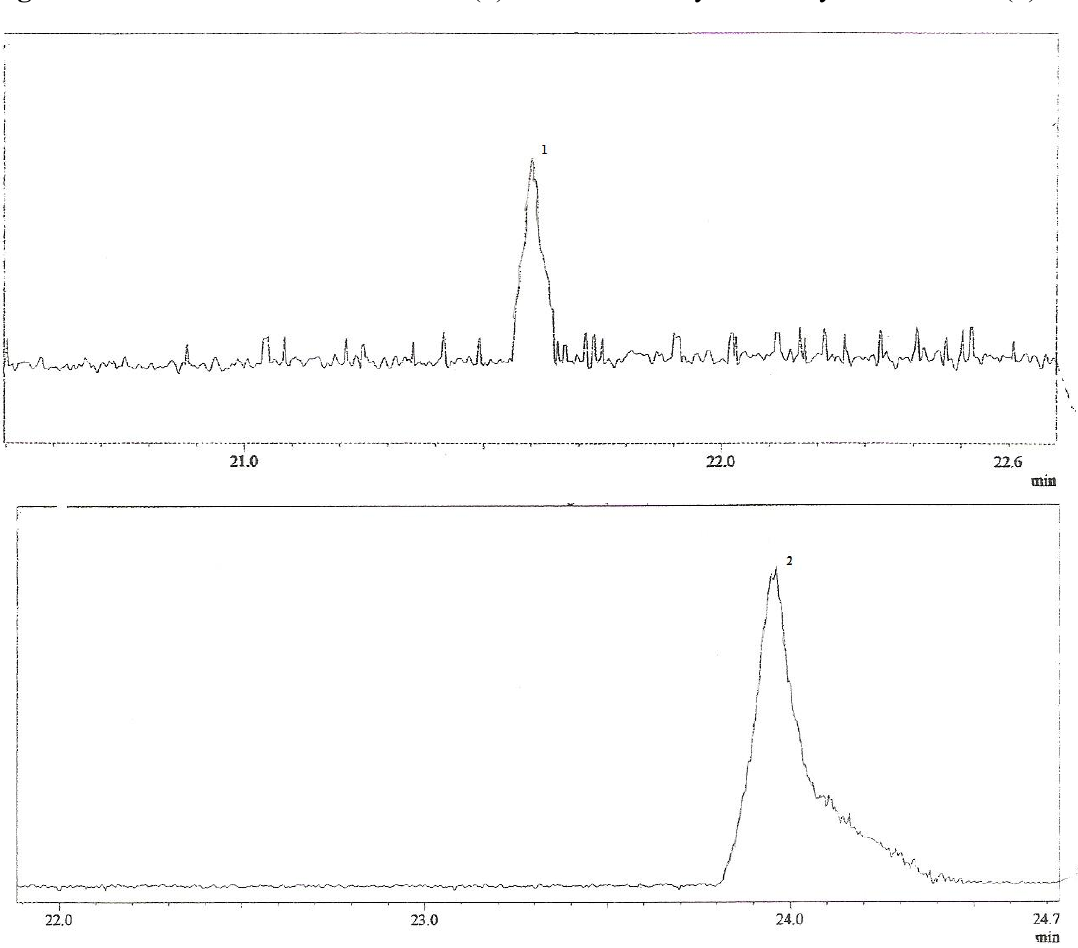
Figure 2. CG of alkaloids voachalotine ( 1 ) and 12-methoxy- N